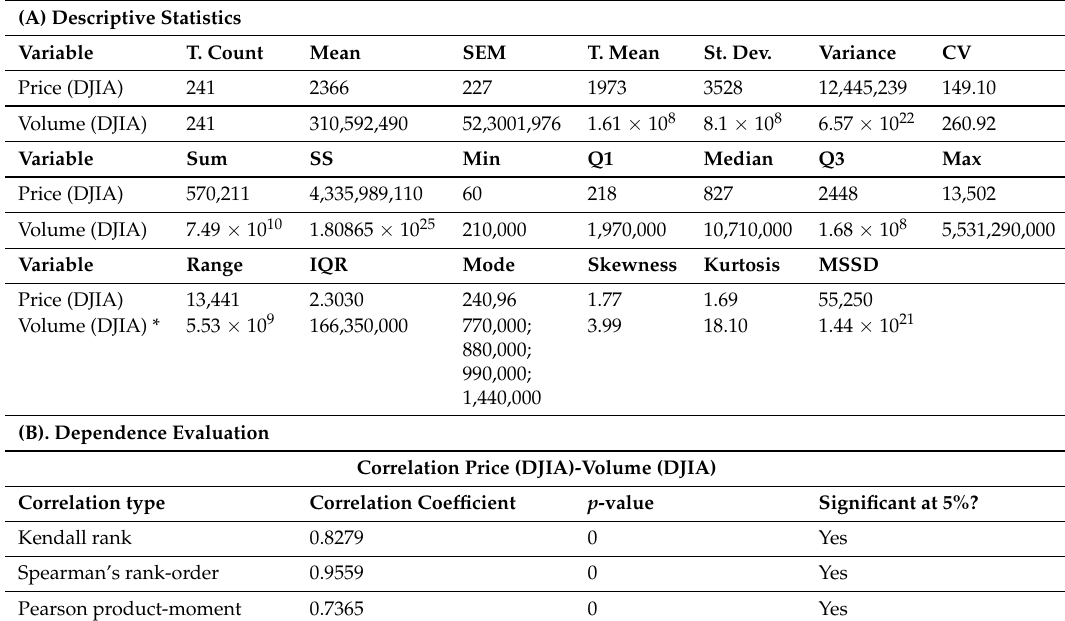
Table 1. Descriptive statistics and dependence evaluation of DJIA price and volume per se